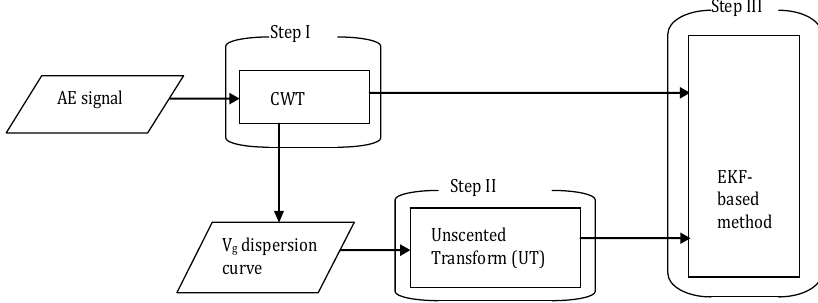
Figure 1. Flowchart of the proposed approach.